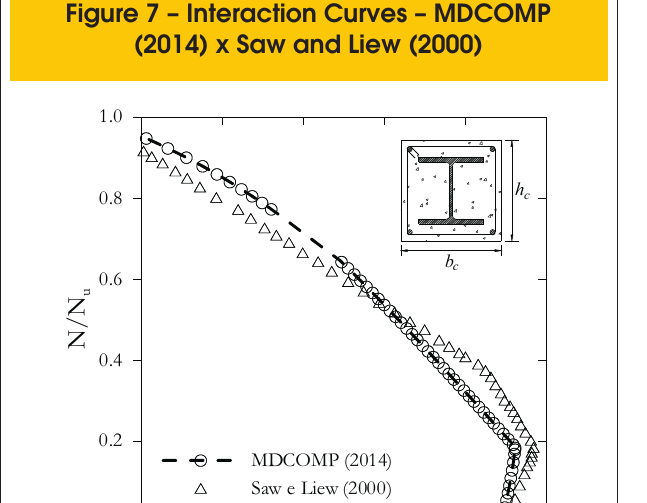
Figure 7 – Interaction Curves – MDCOMP Figure 8 – Interaction Curves –